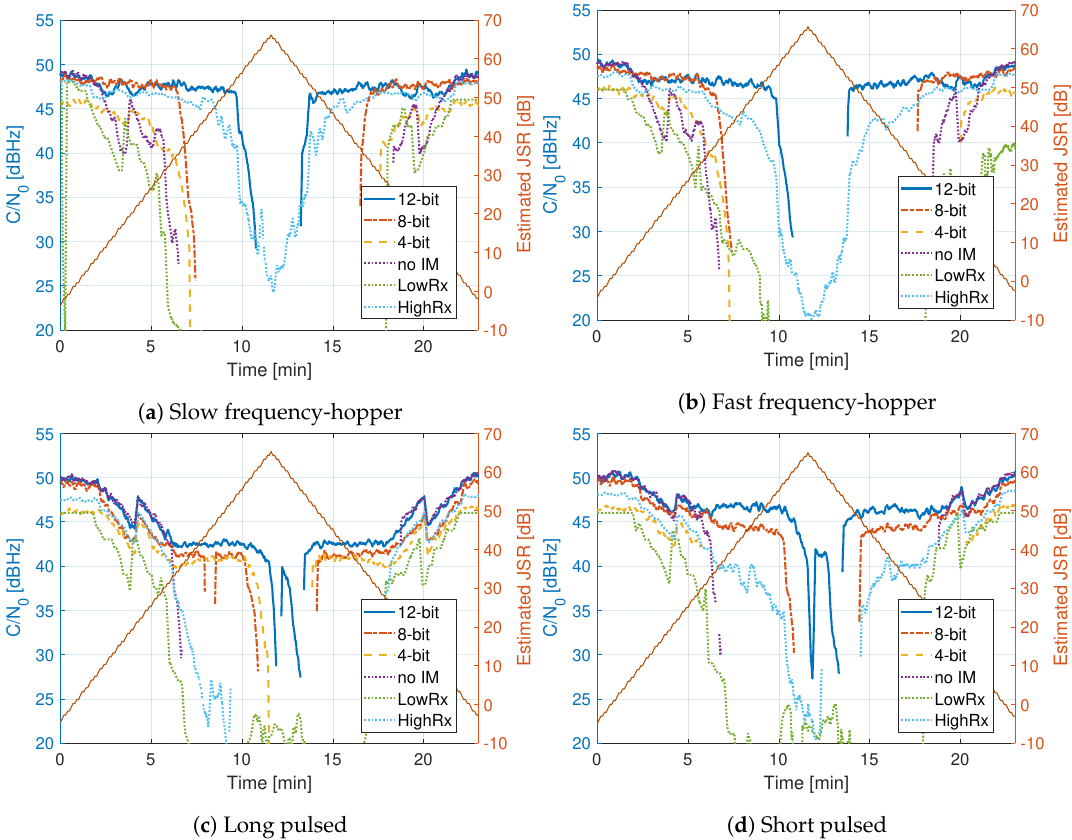
Figure 15. Comparison of tracking